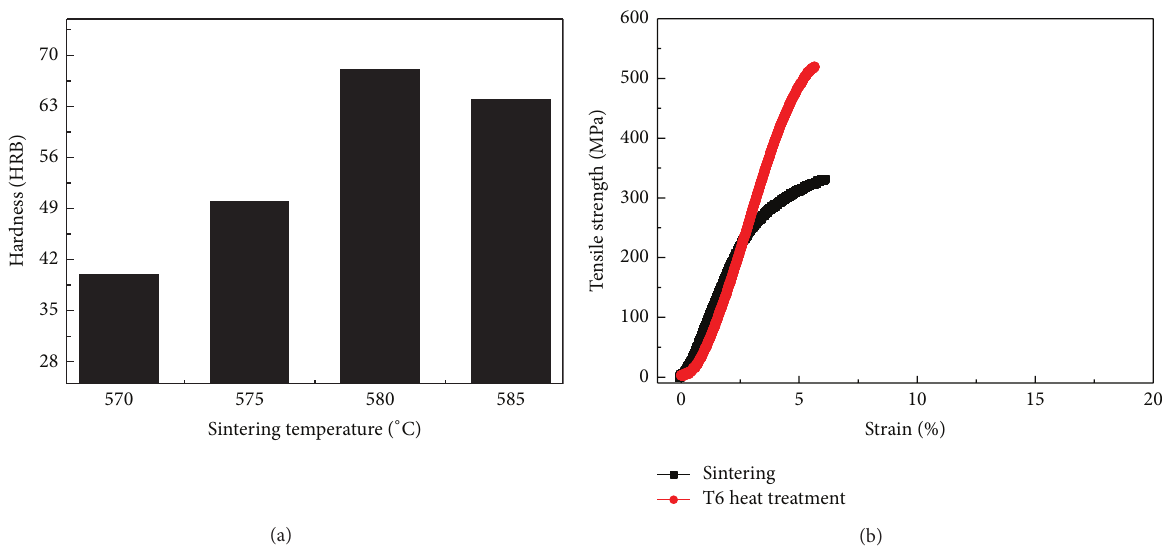
Figure 7: (a) Hardness and (b) stress-strain curve at tensile test of Alumix 431D before and after T6 heat treatment (for 580 ∘ C sintering temperature).